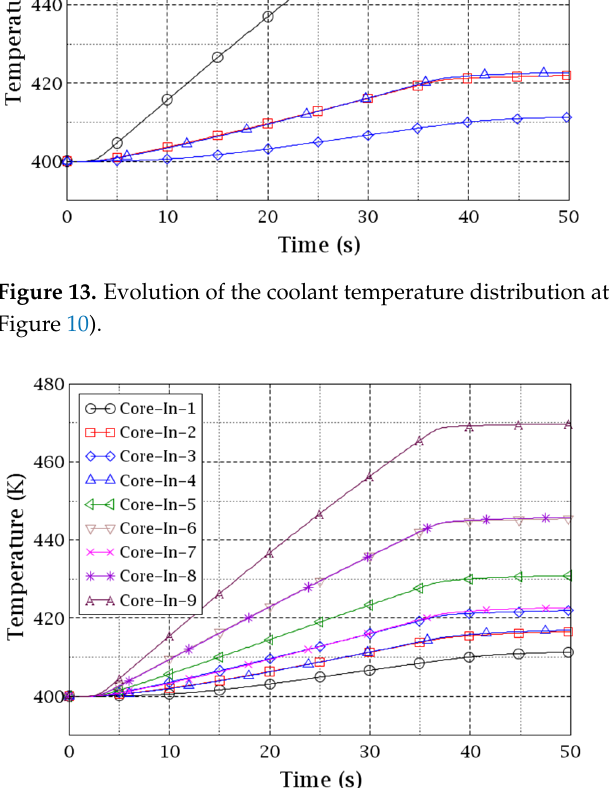
Figure 15. Evolution of the coolant temperature distribution at the core outlet CY-V (cell index is from Figure 10).